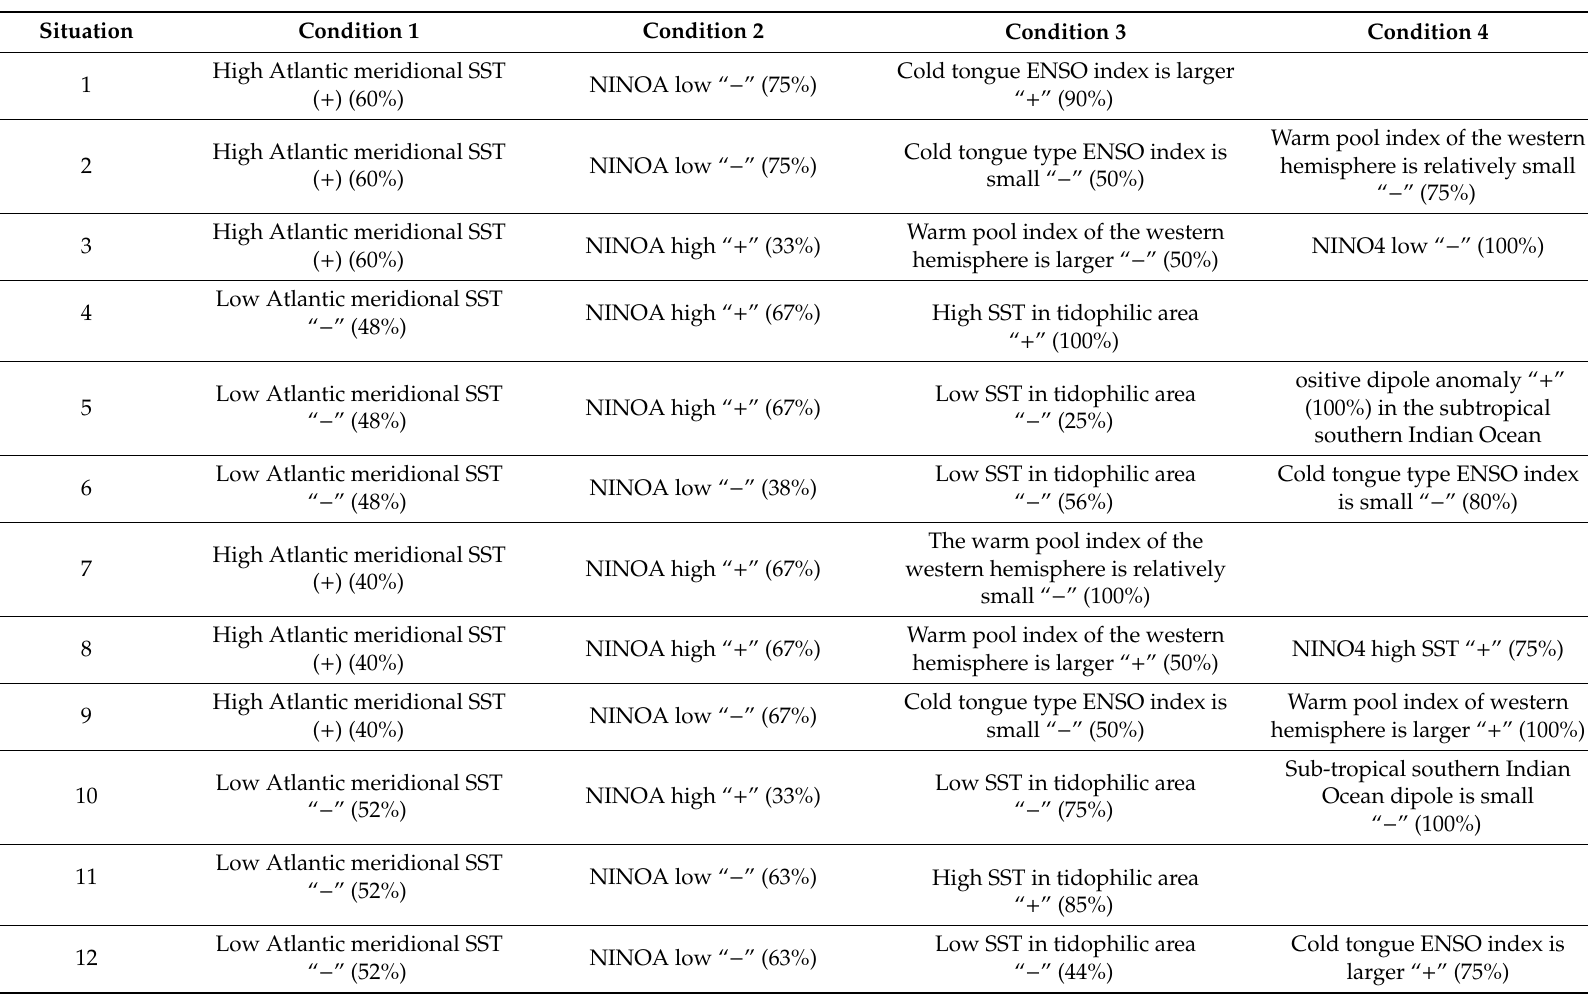
Table 3. Combination of summer precipitation trend and prewinter Sea Surface Temperature (SST) model based on the CART algorithm in